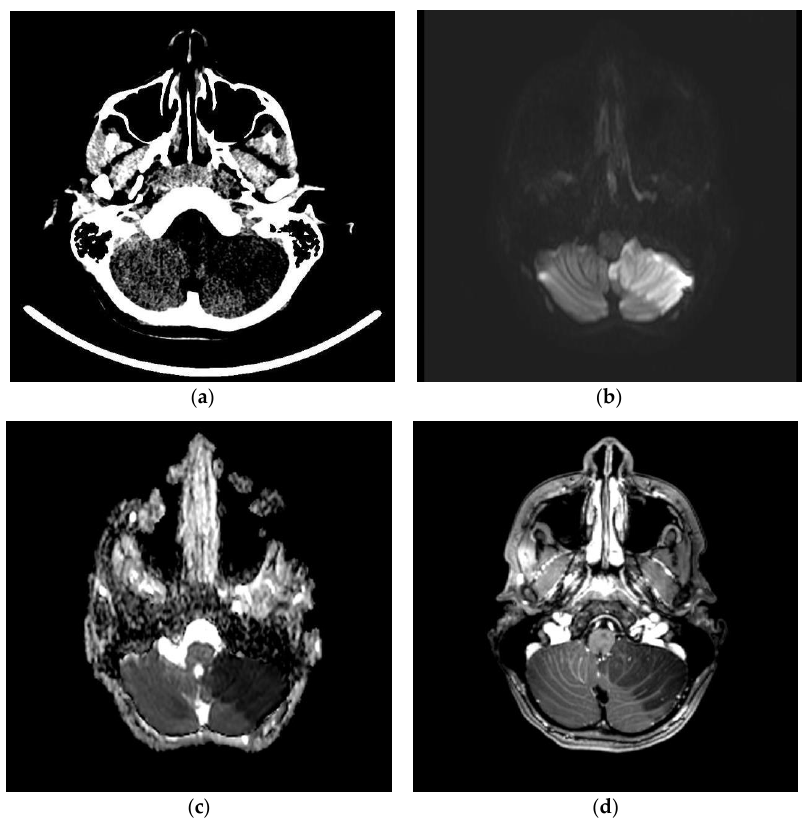
Figure 2. Acute left cerebellar infarct in the distribution of the posterior inferior cerebellar artery (PICA) without mass effect and enhancement areas. Axial brain CT scan ( a ) and axial brain MRI images of DWI ( b ), ADC ( c ), and T1- WI after intravenous gadolinium contrast administration ( d ) sequences. Brain or spinal cord MRI, performed in 12 patients (9.8%), was altered in five (4.1%). In the above-mentioned 12-year-old boy, it showed an ischemic injury of the left cerebel- lum cortex (Figure 2b – d), and the left posterior inferior cerebellar artery (PICA) was un- recognizable in the angiographic sequences. Multiple thalamic ischemic injuries were found also in a 15-year-old boy with confusion and loss of consciousness. In the patient with GBS, the spinal cord MRI showed contrast enhancement of cauda equina roots. In the 10-month-old infant with MIS-C and cerebral oedema on CT, mild cerebral atrophy and areas of altered signal were revealed at MRI performed 2 weeks after the CT scan. In a two-year-old boy with MIS-C and impairment of consciousness, a second MRI, per- formed after one month from the clinical onset, showed diffuse cortical and subcortical brain atrophy. The three patients with stroke underwent cerebral DSA, which was normal in all but the boy with the cerebellar stroke. The instrumental data are shown in Table 3. Table 3. Altered instrumental and radiological examinations. Tests